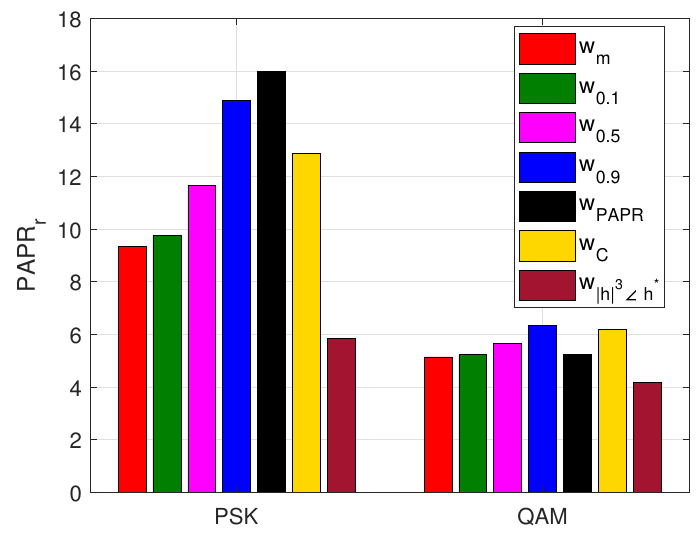
Figure 10. PAPR of the received signals using multisine PSK modulation and QAM modulation using the proposed pre-equalizers of an 8-tone based SWIPT of bandwidth 1